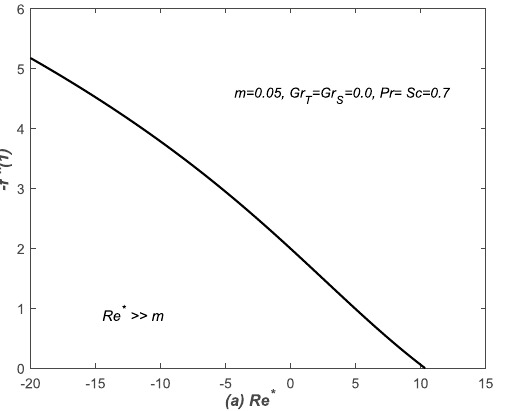
Figure 5. The skin friction coefficient ( − f ′′ ( 1 ) ) is plotted against modified Reynolds number Re ∗ = mRe for m << Re ∗